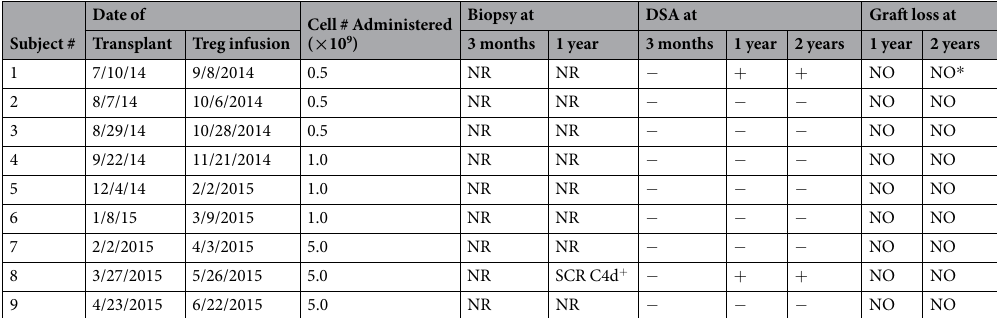
Table 2. Clinical Outcomes of Treg cell infusion within renal transplant recipients. (NR) defined as no rejection; (SCR) defined as subclinical rejection with C4d + staining on biopsy. (DSA) defined as donor specific antibodies. * Developed recurrence of original disease in second year post